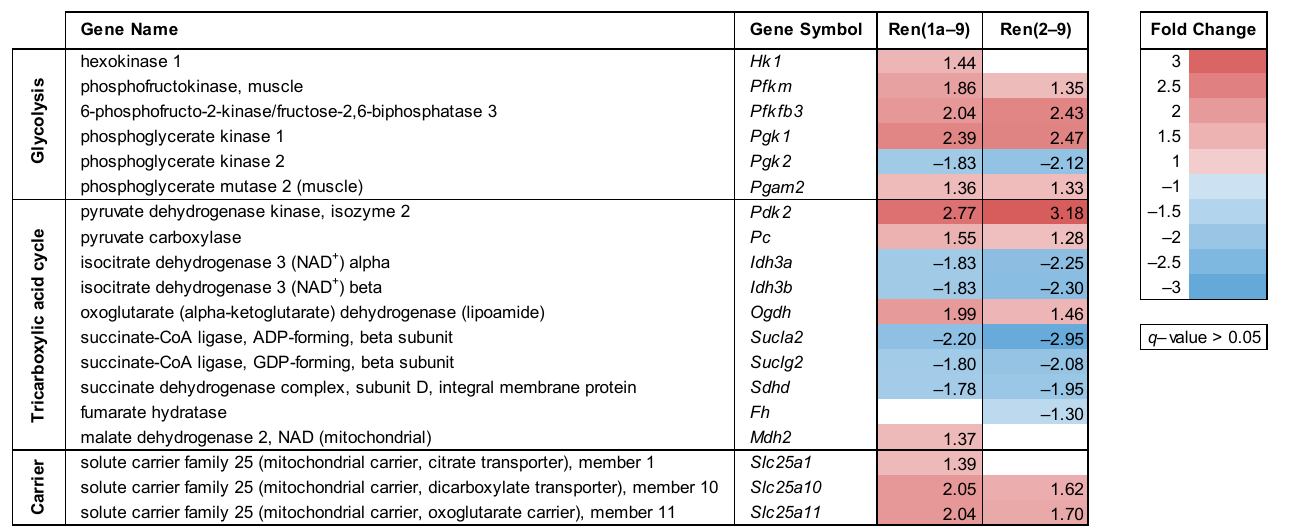
Figure 2. Alterations in the expression of genes involved in glycolysis, the tricarboxylic acid (TCA) cycle, and mitochondrial transport. The transcript levels were identified by microarray analyses as a result of either Ren(1a–9) or Ren(2–9) overexpression as compared with pIRES H9c2 control cells. The red color indicates genes with increased and the blue color indicates those with decreased mRNA levels as compared with pIRES controls, while the white color indicates genes that were not significantly altered with q > 0.05. Shown are only significantly altered genes ( q < 0.05) that exhibit a fold change ≥ |1.3| in at least one group comparison.